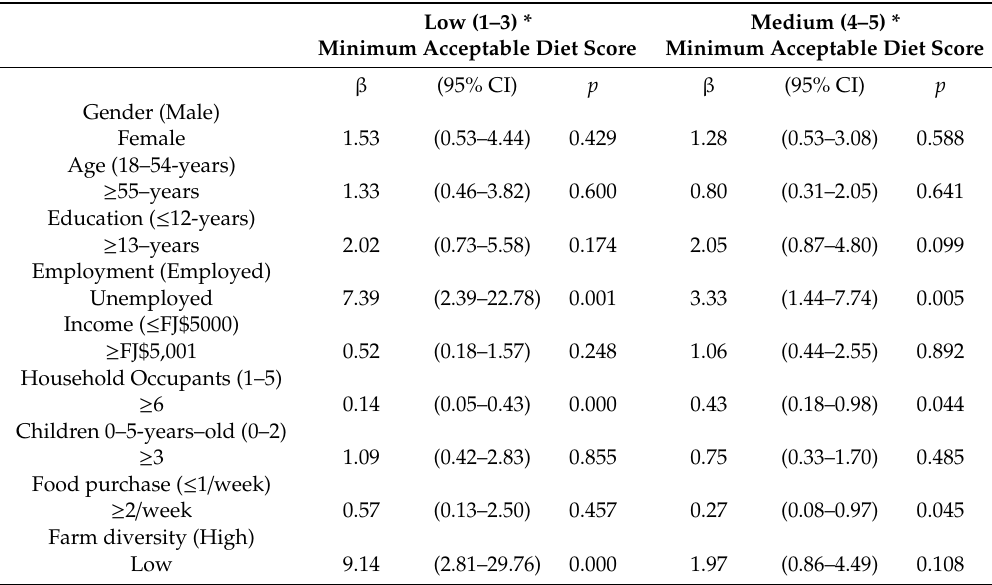
Table 4. Univariate associations between socioeconomic characteristics and dietary diversity ( n =